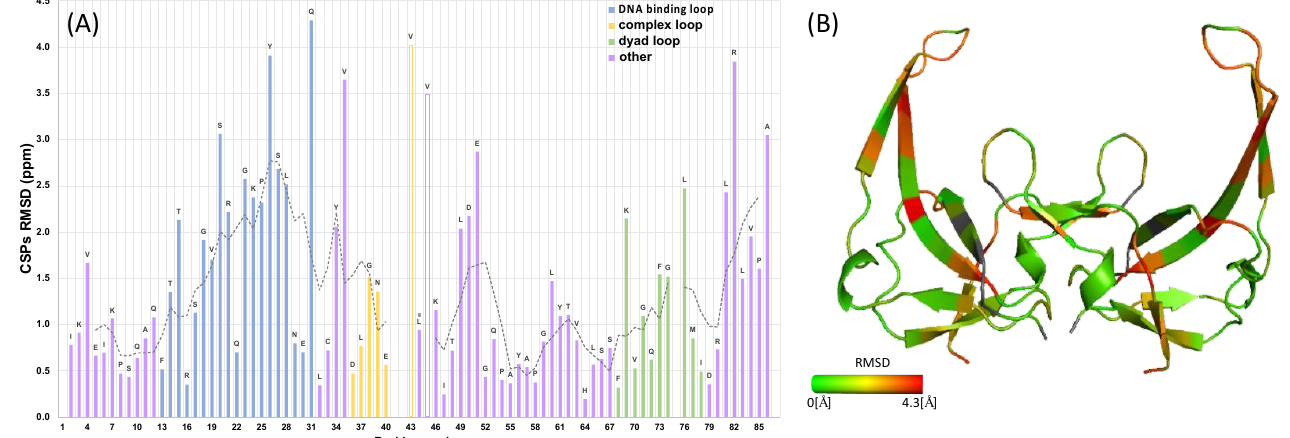
Figure 9. Weighted RMSD values extracted from chemical shift perturbations of free and bound gVp. ( A ) RMSD plot calculated by giving the 15 N shifts one-quarter the weight of carbons. The different regions of the protein are colored as follows: blue, DNA binding loop (residues 13–31); yellow, complex loop (residues 36–43); green, dyad loop (residues 68–78); purple, remainder of the protein. A five-point moving average was plotted as a dashed line. There were no data for residues 1, 41, 42, and 87. ( B ) RMSD values plotted on the structure of the dimer structure from X-ray crystallography (pdb id 1vqb).